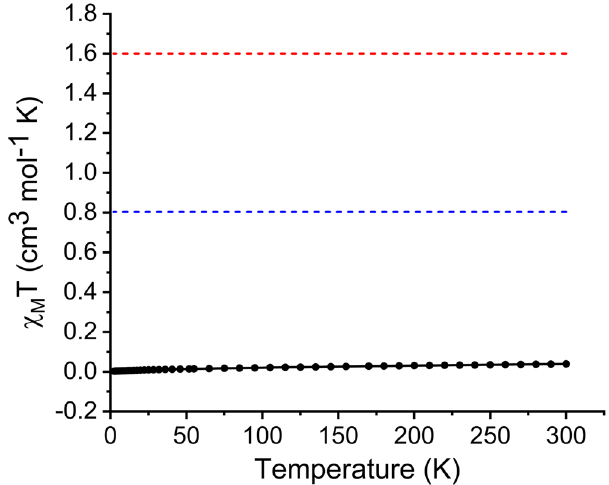
external 1 T fi eld. Experimental data points are represented by black circles and the line is a guide to the eye only. For comparison, the hypothetical magnetic moments of 5 f 1 and 5 f 2 ions are represented by the blue and red dotted lines,